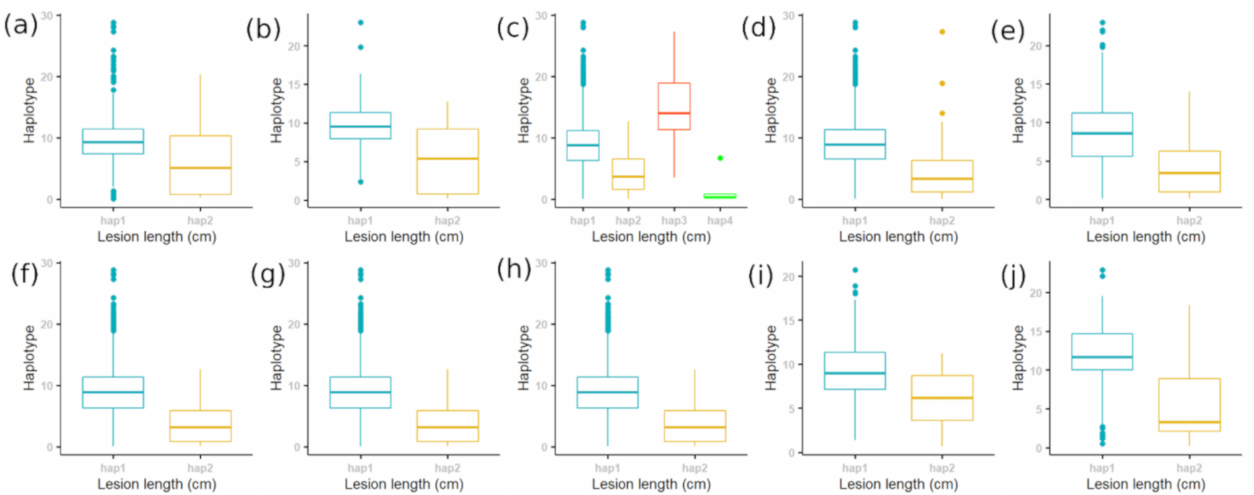
Figure 8. Boxplots indicating phenotypic responses in BLB resistance among rice accessions featuring alternative haplo- types determined by occurrence of significantly associated SNPs identified by GWAS analysis. ( a ) LOC_Os11g31620; ( b ) LOC_Os11g32210; ( c ) LOC_Os11g40840; ( d ) LOC_Os11g45620; ( e ) LOC_Os11g37860; ( f ) LOC_Os11g37870;